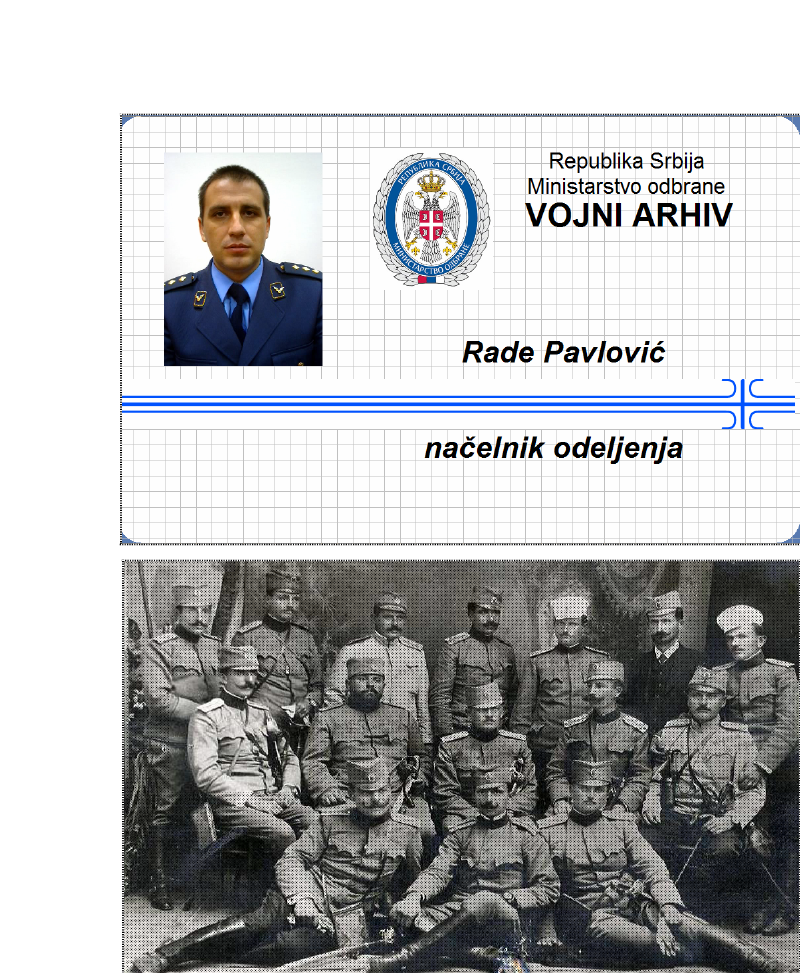
Figure 11 – View of a card in the card-making